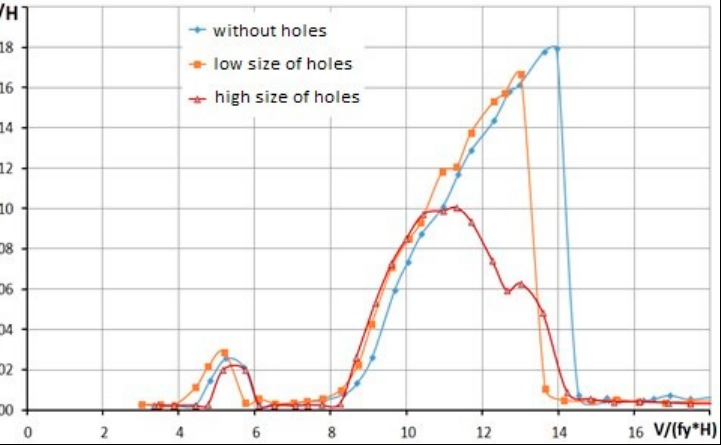
Figure 11. The effect of wall permeability (perforation) on the intensity of oscillations of the initial configuration of the model.